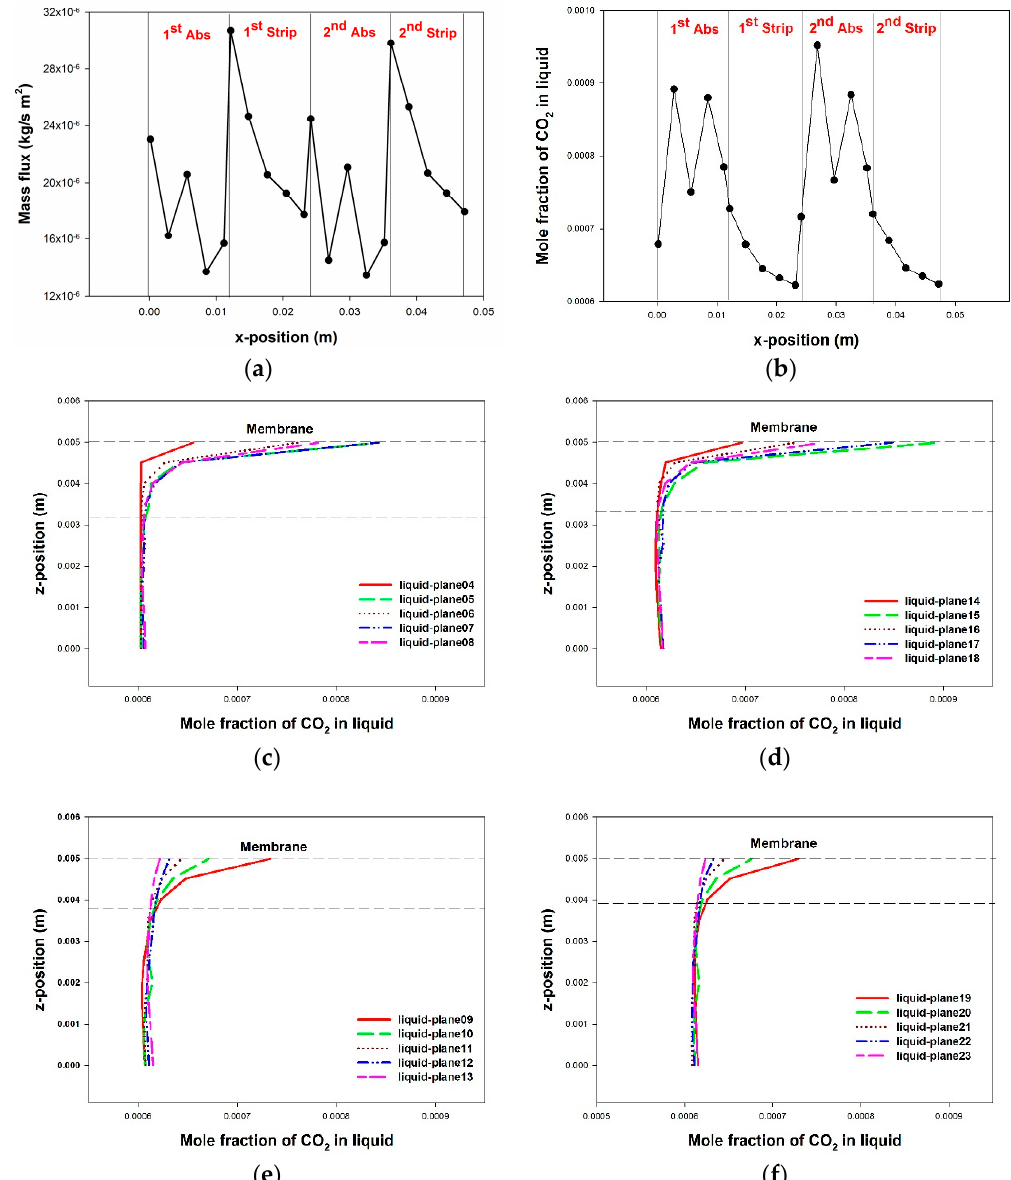
Figure 11. CS-HASMC BC internal profiles (( a ) transmembrane CO 2 mass flux, ( b ) membrane surface liquid CO 2 concentration, ( c ) first absorber, (liquid entry: liquid-plane04), ( d ) second absorber (liquid entry: liquid-plane14), ( e ) first stripper (liquid entry: liquid-plane09), ( f ) second stripper (liquid entry: liquid-plane19), ( c – f ) CO 2 concentration profiles in liquid channel).